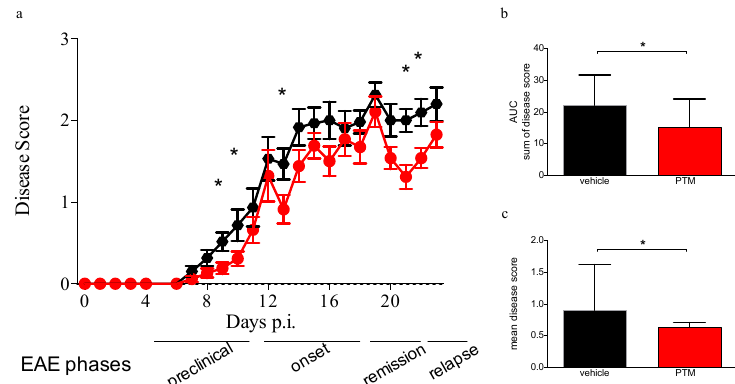
Figure 1. Clinical signs of neuroinflammation and demyelination of relapsing–remitting experimental autoimmune encephalomyelitis (RR–EAE) are ameliorated by pentamidine. ( a ) Clinical symptoms score (CSS) from day 1 to day 23 p.i. of 32 EAE-affected animals (4 mice were withdrawn from the experiments because of excessive reaction to immunization, unresponsiveness/anergy to immunization, or death for unknown causes), pentamidine isethionate (PTM)-treated (red) and vehicle treated (black). The circles and confidence bars represent the mean and the standard deviation of the CSS of the entire group of mice for each day p.i. Statistically significant di ff erences of the CSS are observed at onset, during remission and at relapse of EAE (Student t -test: p = 0.02 at day 9 p.i.; p = 0.05 at day 10 p.i.; p = 0.04 at day 13 p.i.; p = 0.002 at day 21 p.i.; p = 0.01 at day 22 p.i.). At onset (days 12–15 p.i.), 10 mice